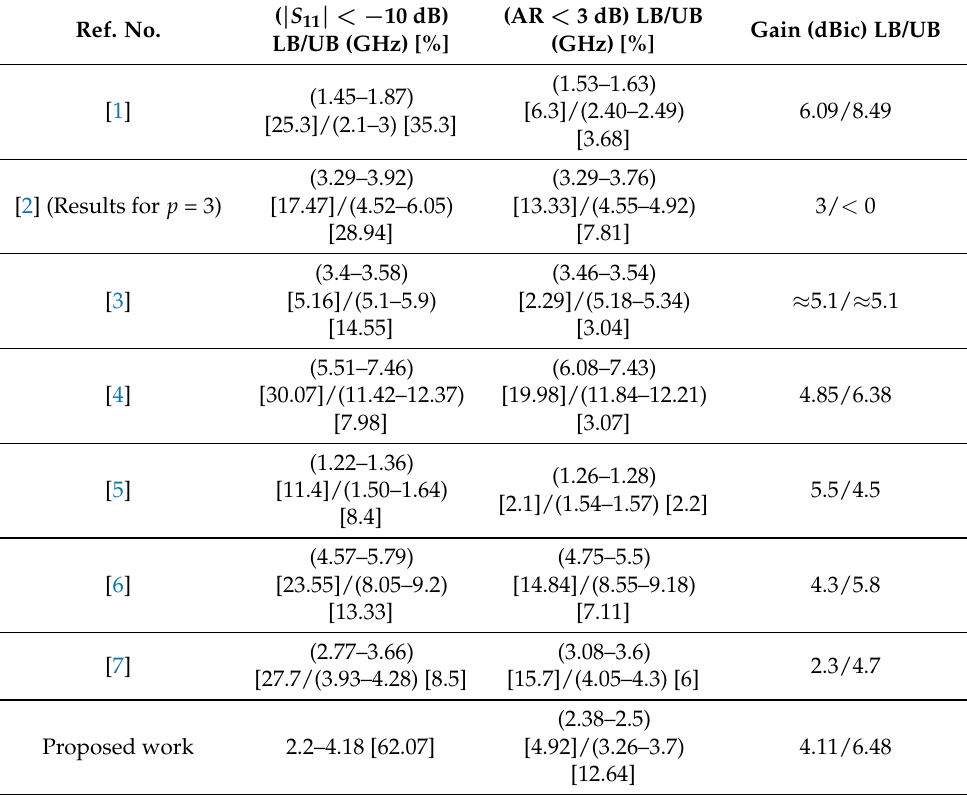
Table 2. Performance comparison of the proposed DRA with earlier dual-band CP DRAs. LB: lower band; UB: upper